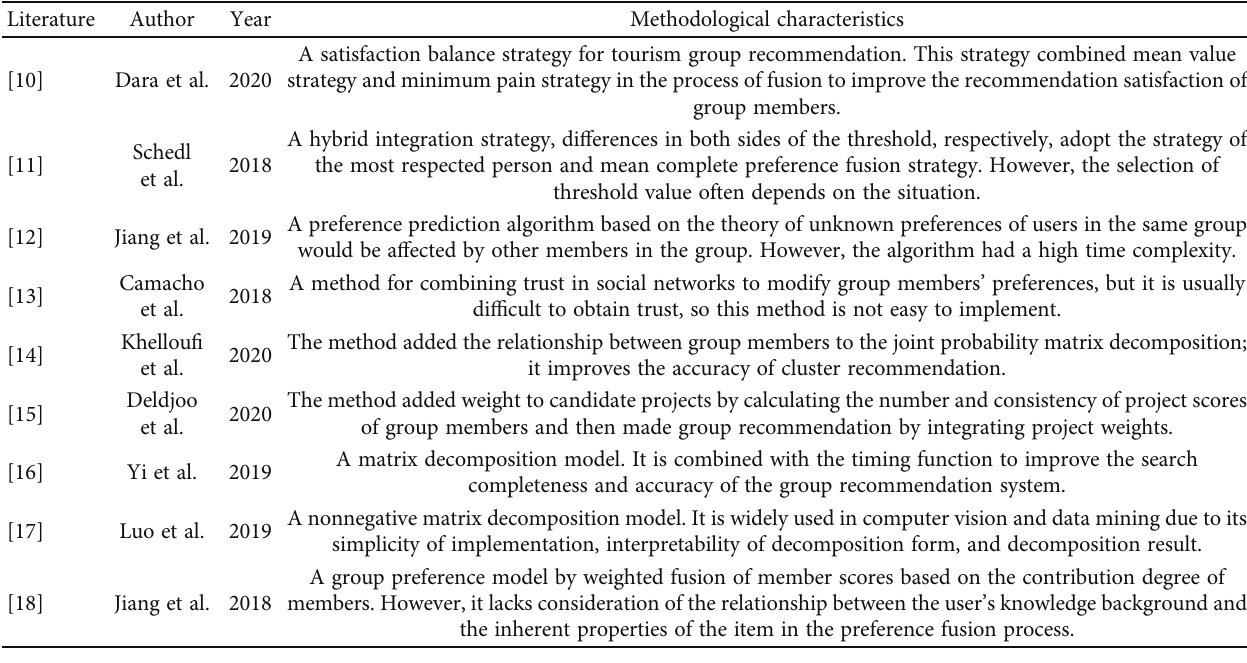
Table 1: Literature review details on recommendation